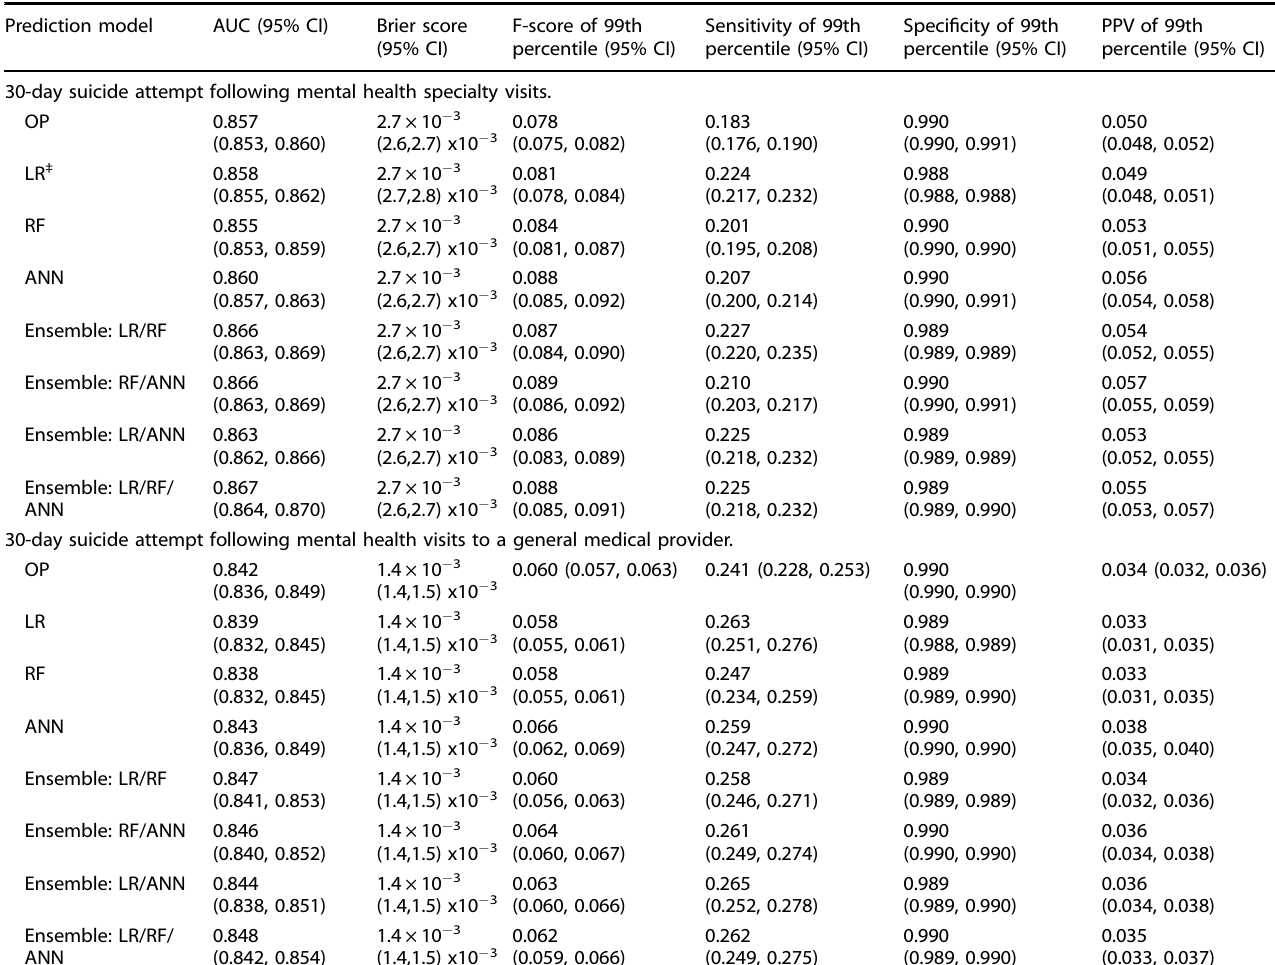
Table 5. Prediction performance in entire validation data for suicide attempt in the 30 days following an outpatient visit; 95% con fi dence intervals (CIs) constructed using 10,000 bootstrap